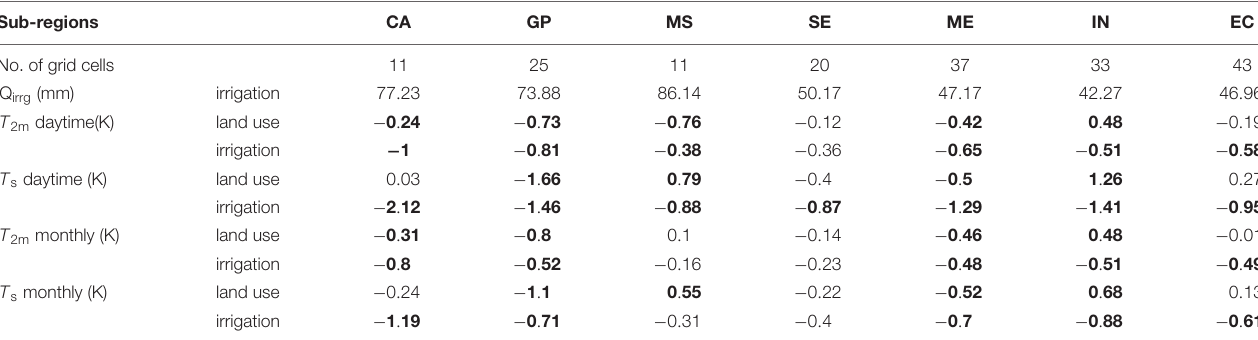
TABLE 3 | Regional average temperature changes due to land use and irrigation in the irrigated grid cells (with total summertime irrigation greater than 30 mm) in seven sub-regions. Bold numbers indicate over half of the grid cells have statistically significant temperature changes at the 95% confidence level. Sub-regions CA GP